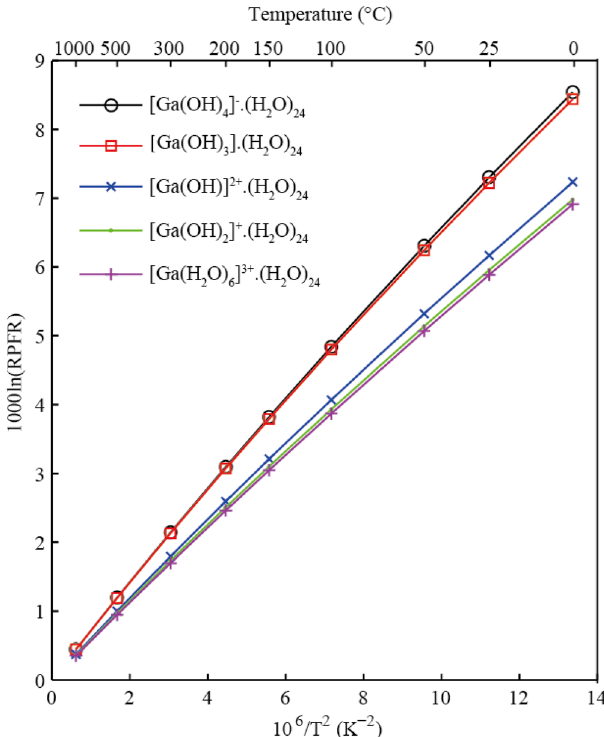
Figure 4. The 10 3 ln(RPFR)s of different Ga-bearing aqueous solutions as a function of temperature.